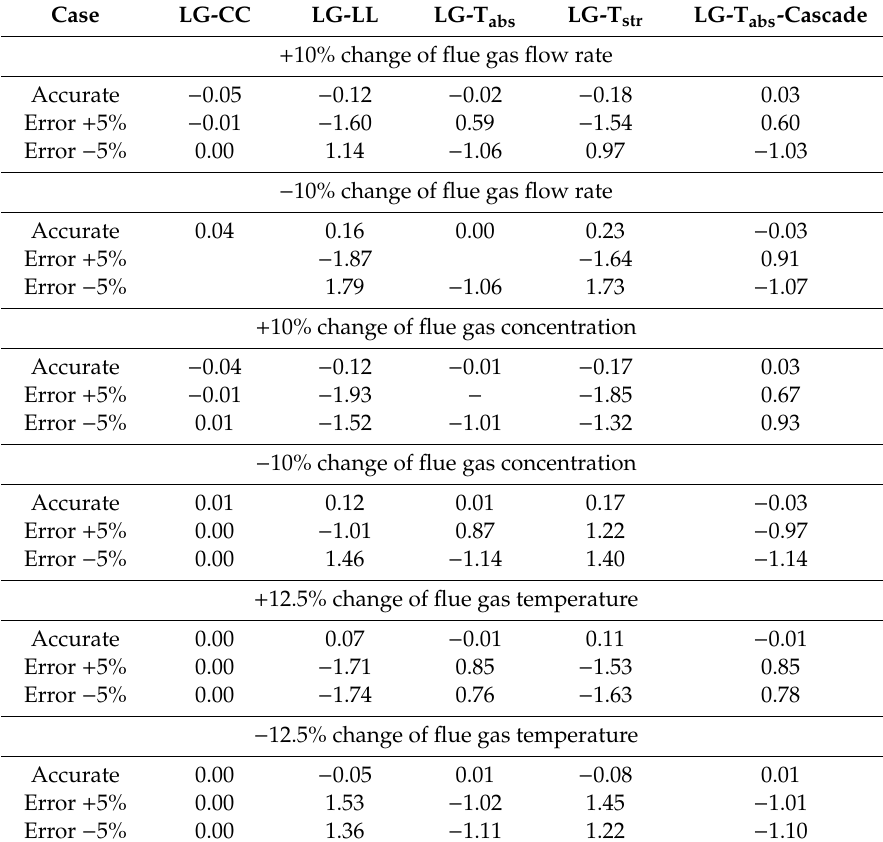
Table 3. E ff ect of model error on the deviation of CO 2 capture e ffi ciency (%) by testing ± 5% error on the optimal values of the controlled